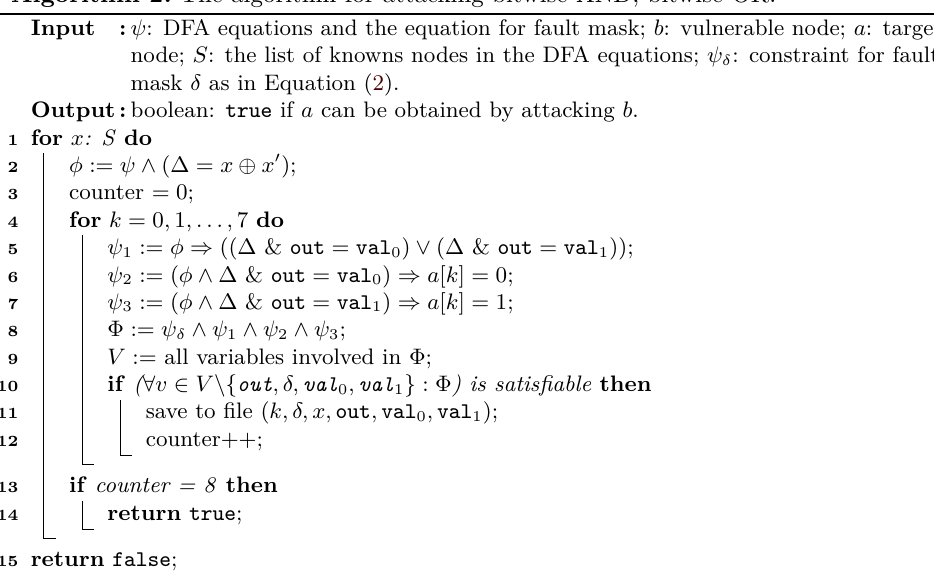
Algorithm 2: The algorithm for attacking bitwise AND, bitwise